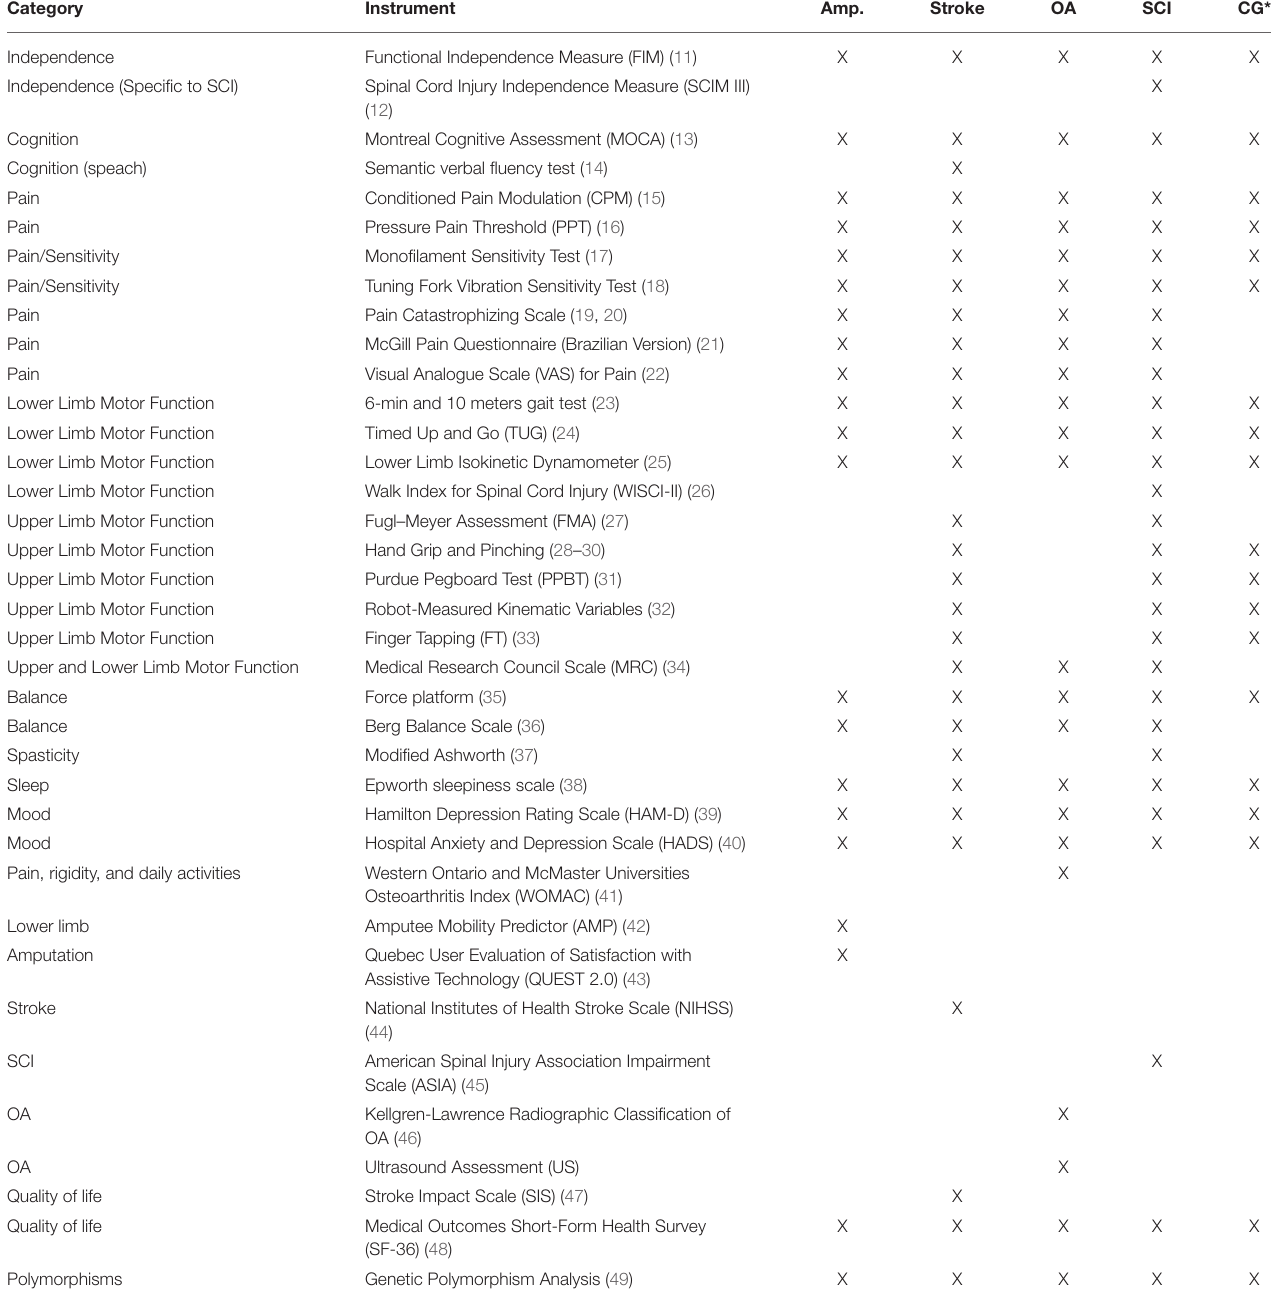
TABLE 1 | Assessment instruments used for each study group.